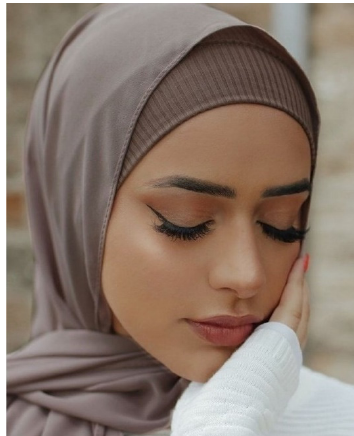
Figure 2. Instagram Post of mf.muslimfashion, https://www.instagram.com/p/CXvqvR9tNIq/ (ac- cessed on 21 December 2021).